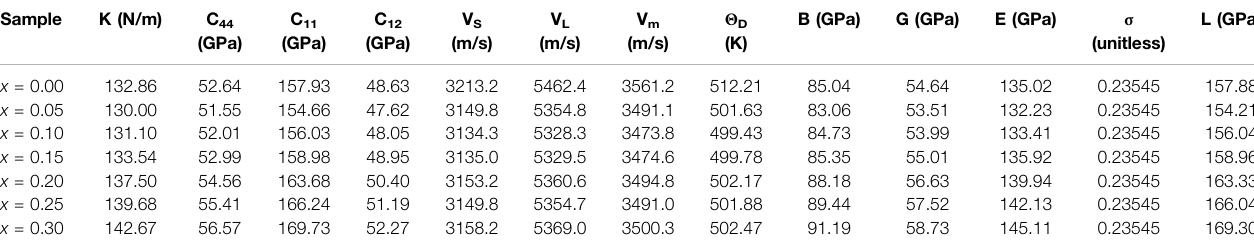
TABLE 3 | Mean force constant ( K ), elastic stiffness constants ( C 11 , C 44 , C 12 ), velocity of longitudinal and shear waves ( V L , V S ), mean velocity ( V m ) and Debye temperature ( Θ D ), longitudinal modulus (L), Poisson ’ s ratio ( σ ), rigidity modulus (G), Young ’ s modulus (E), and bulk modulus (B) for Mn 0.3- x Ba x Cu 0.2 Zn 0.5 Fe 2 O 4 nanoparticles.